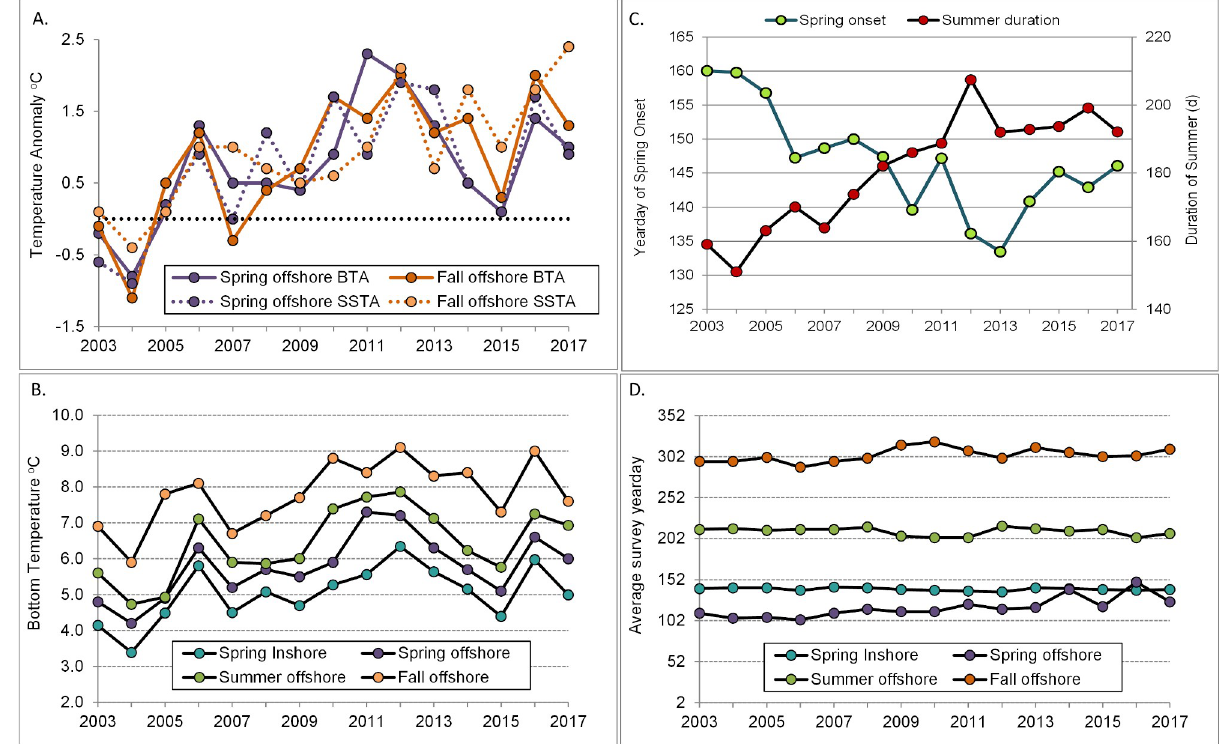
Fig 4. Bottom and surface water temperature and seasonal phenology for the study area. (A.) Bottom and surface temperature anomalies (BTA and SSTA, respectively) for NEFSC spring and fall surveys. Anomalies correct for variation in timing of surveys; (B.) stratified mean bottom temperature for spring, summer and fall surveys; (C.) estimated yearday of spring onset and duration of summer in the western Gulf of Maine; (D.) average survey date (yearday).